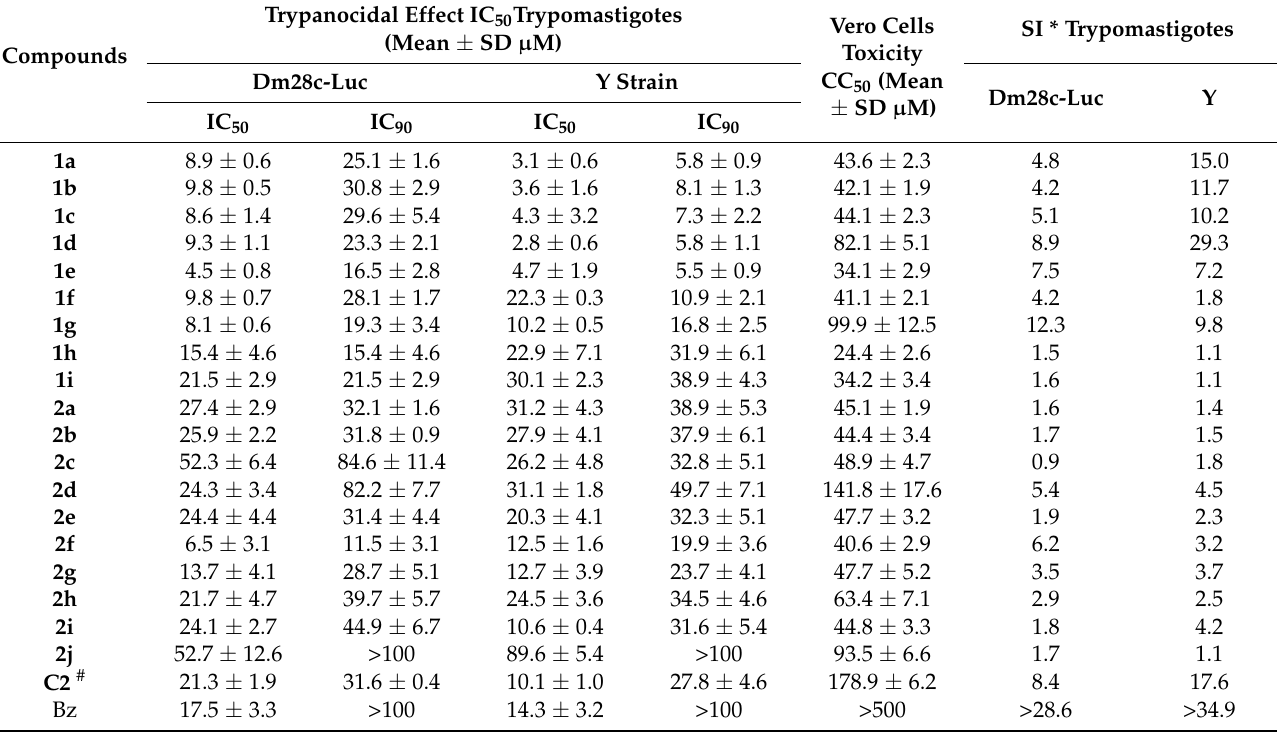
Table 1. Cytotoxicity and trypanocidal effect of 1,4-naphthoquinone derivatives against trypomastigote forms of T. cruzi. Trypanocidal Effect IC 50 Compounds